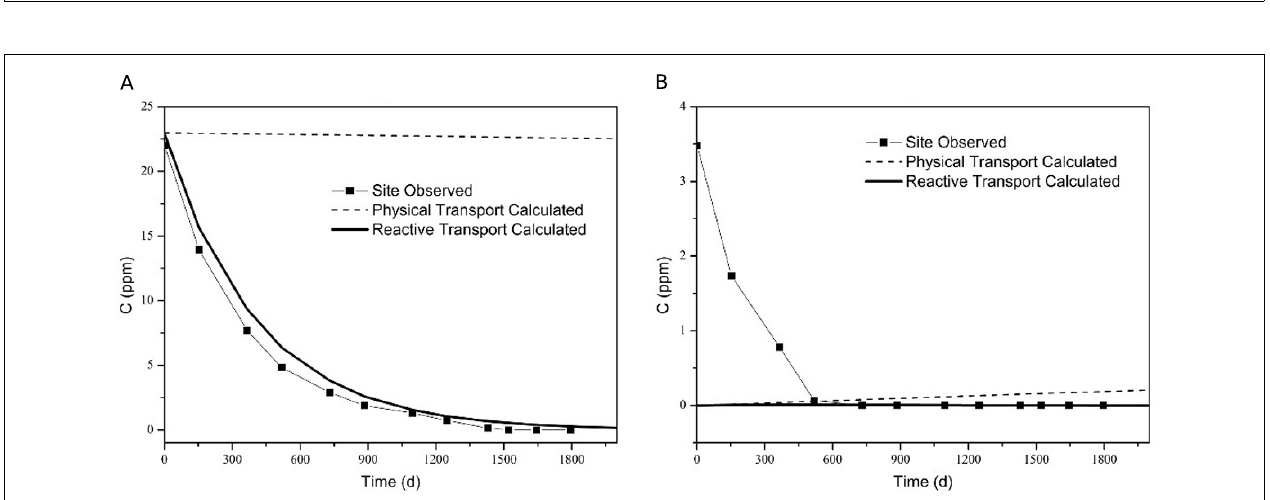
FIGURE 3 | Comparison between the observed and calculated concentrations [(A) MW-5–4 m (MSE = 1.29), (B) MW-5–6 m (MSE = 1.